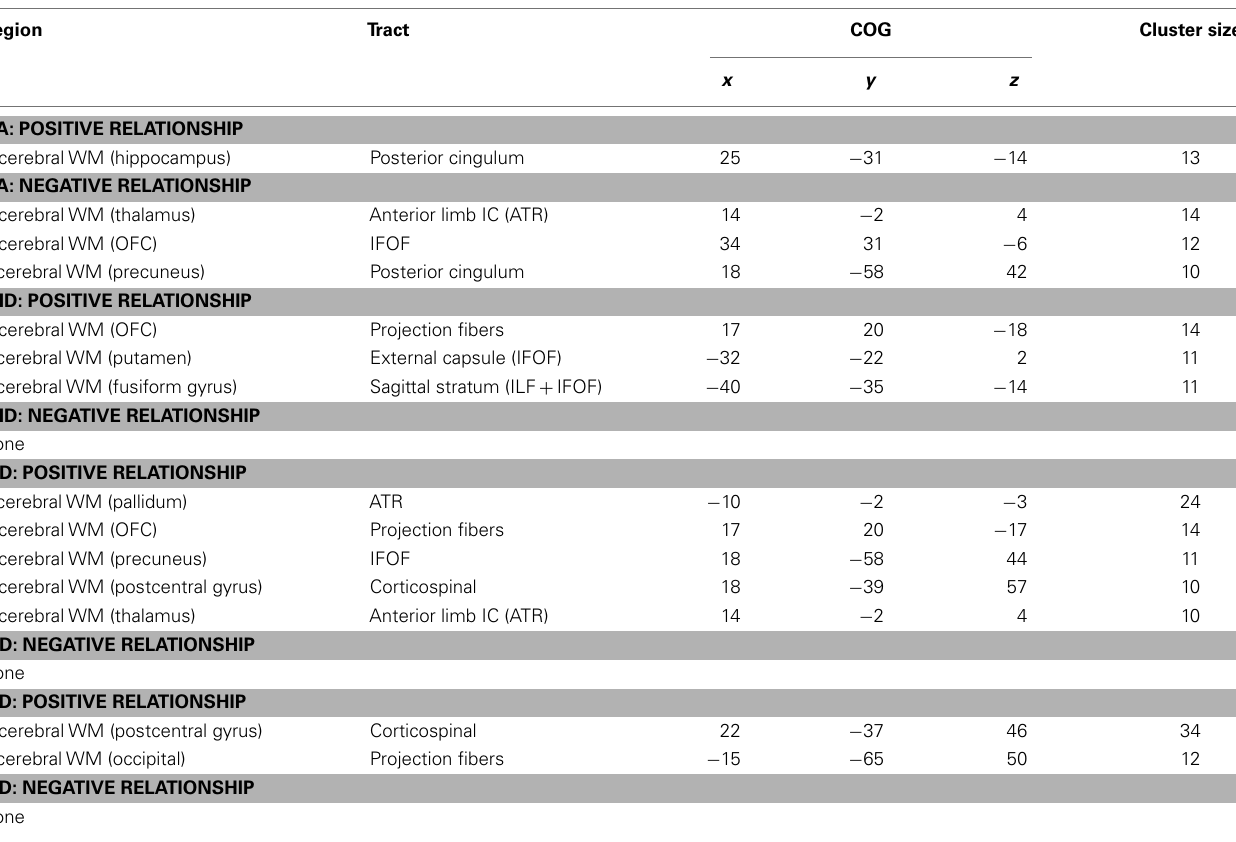
Table 4 |Voxel-wise correlations with